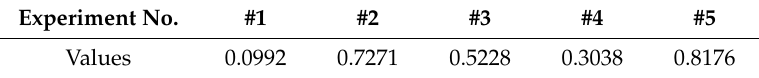
Table 1. SSI T values of the vibration signals shown in Figure 7.